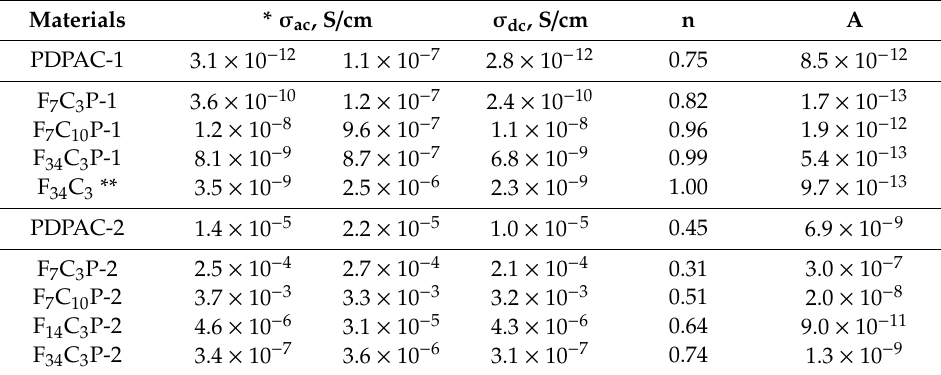
Table 3. The conductivity values of